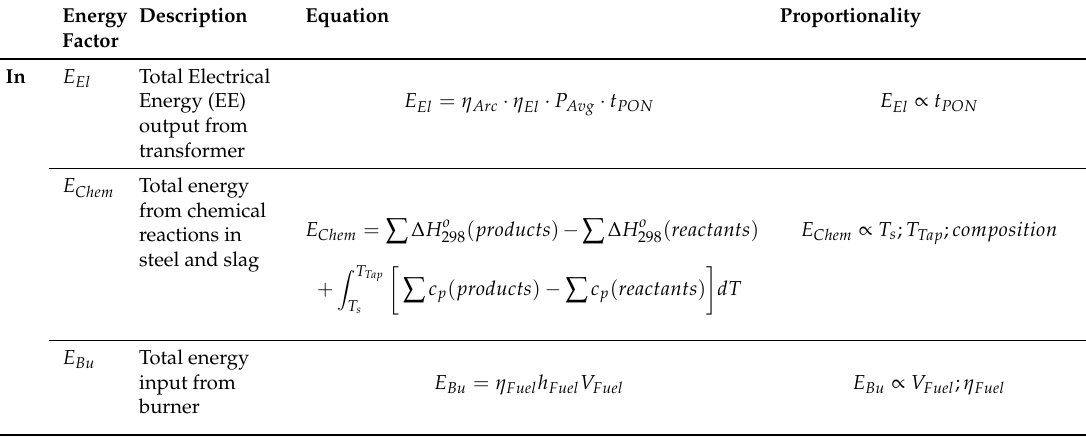
Table 1. Ingoing and outgoing energy terms governing the energy balance equation of the Electric Arc Furnace (EAF)